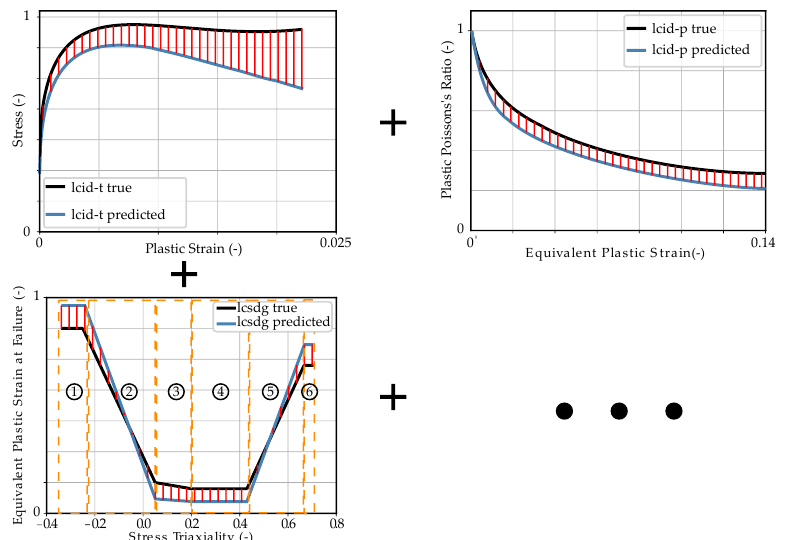
Figure 11. Exemplary calculation of the MSE of the material card input curves from true and predicted values and summation to the loss value (for EPSF vs. TRI separate curve